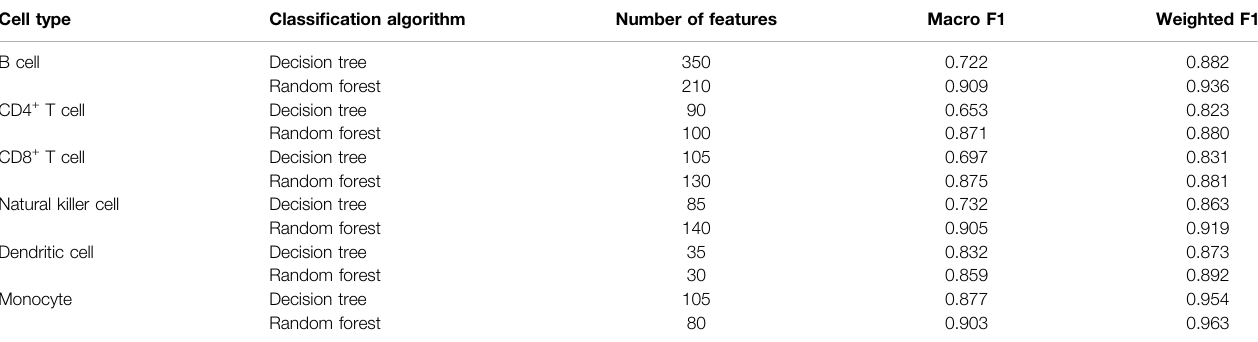
TABLE 2 | Performance of the optimum classi fi ers based on different classi fi cation algorithms on six cell types. Cell type Classi fi cation algorithm Number of features Macro F1 Weighted F1 B